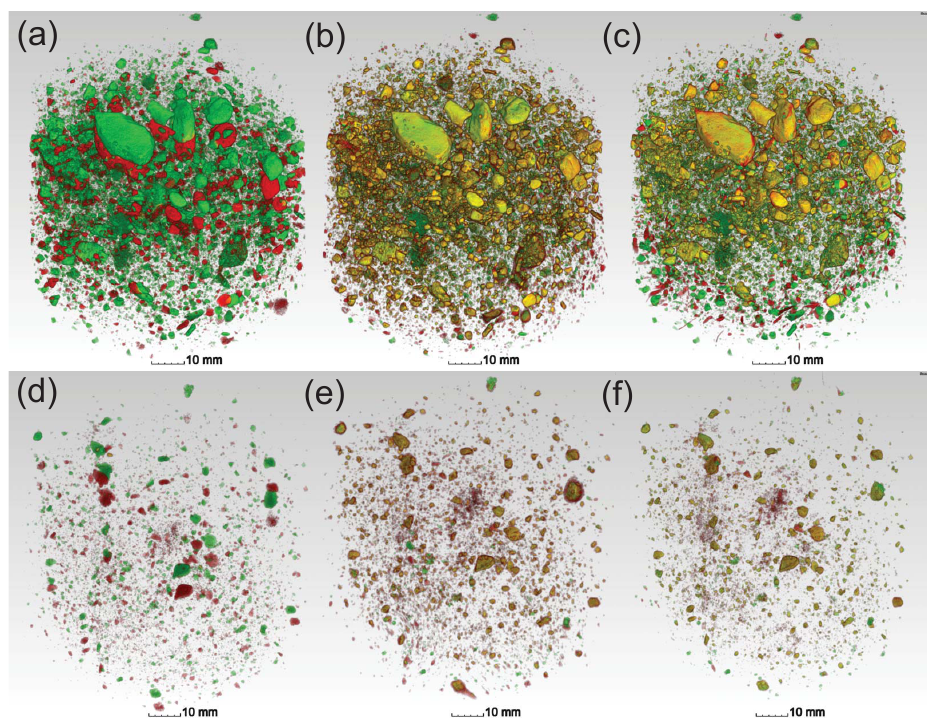
Figure 5. The spatial alignment of rocks between the saturated soil (green) and the soil at ψ = − 500kPa (red) before (a) and after (b) elastic registration image registration of the rock matrix in the Köllme soil. Note that the co-occurrence of rocks results in a composite, yellowish color. The spatial alignment of rocks is less accurate in the bottom of the sample, when the entire grayscale range is used for image registration (c) . Same is shown for the Bad Lauchstädt soil (d–f) . There, both strategies, with and without contrast enhancement for rocks, lead to equally good spatial alignment of the rock